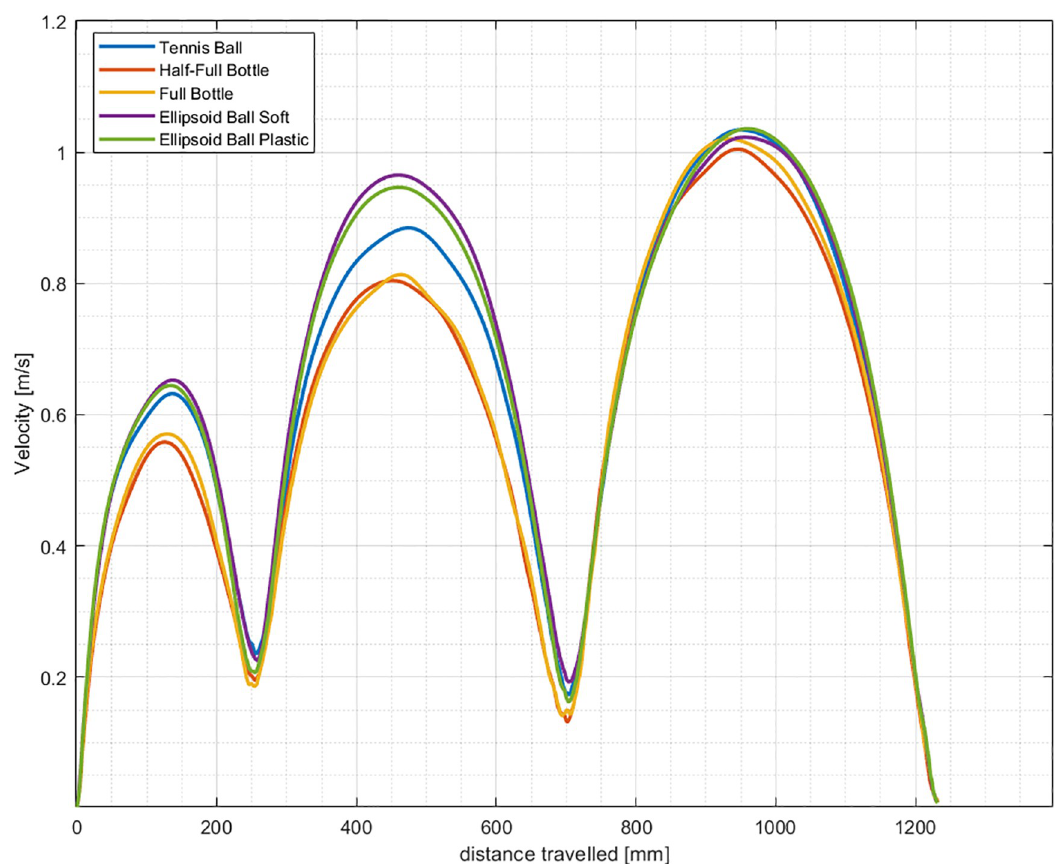
Fig 6. Velocity profiles values averaged over 31 subjects during the object manipulation